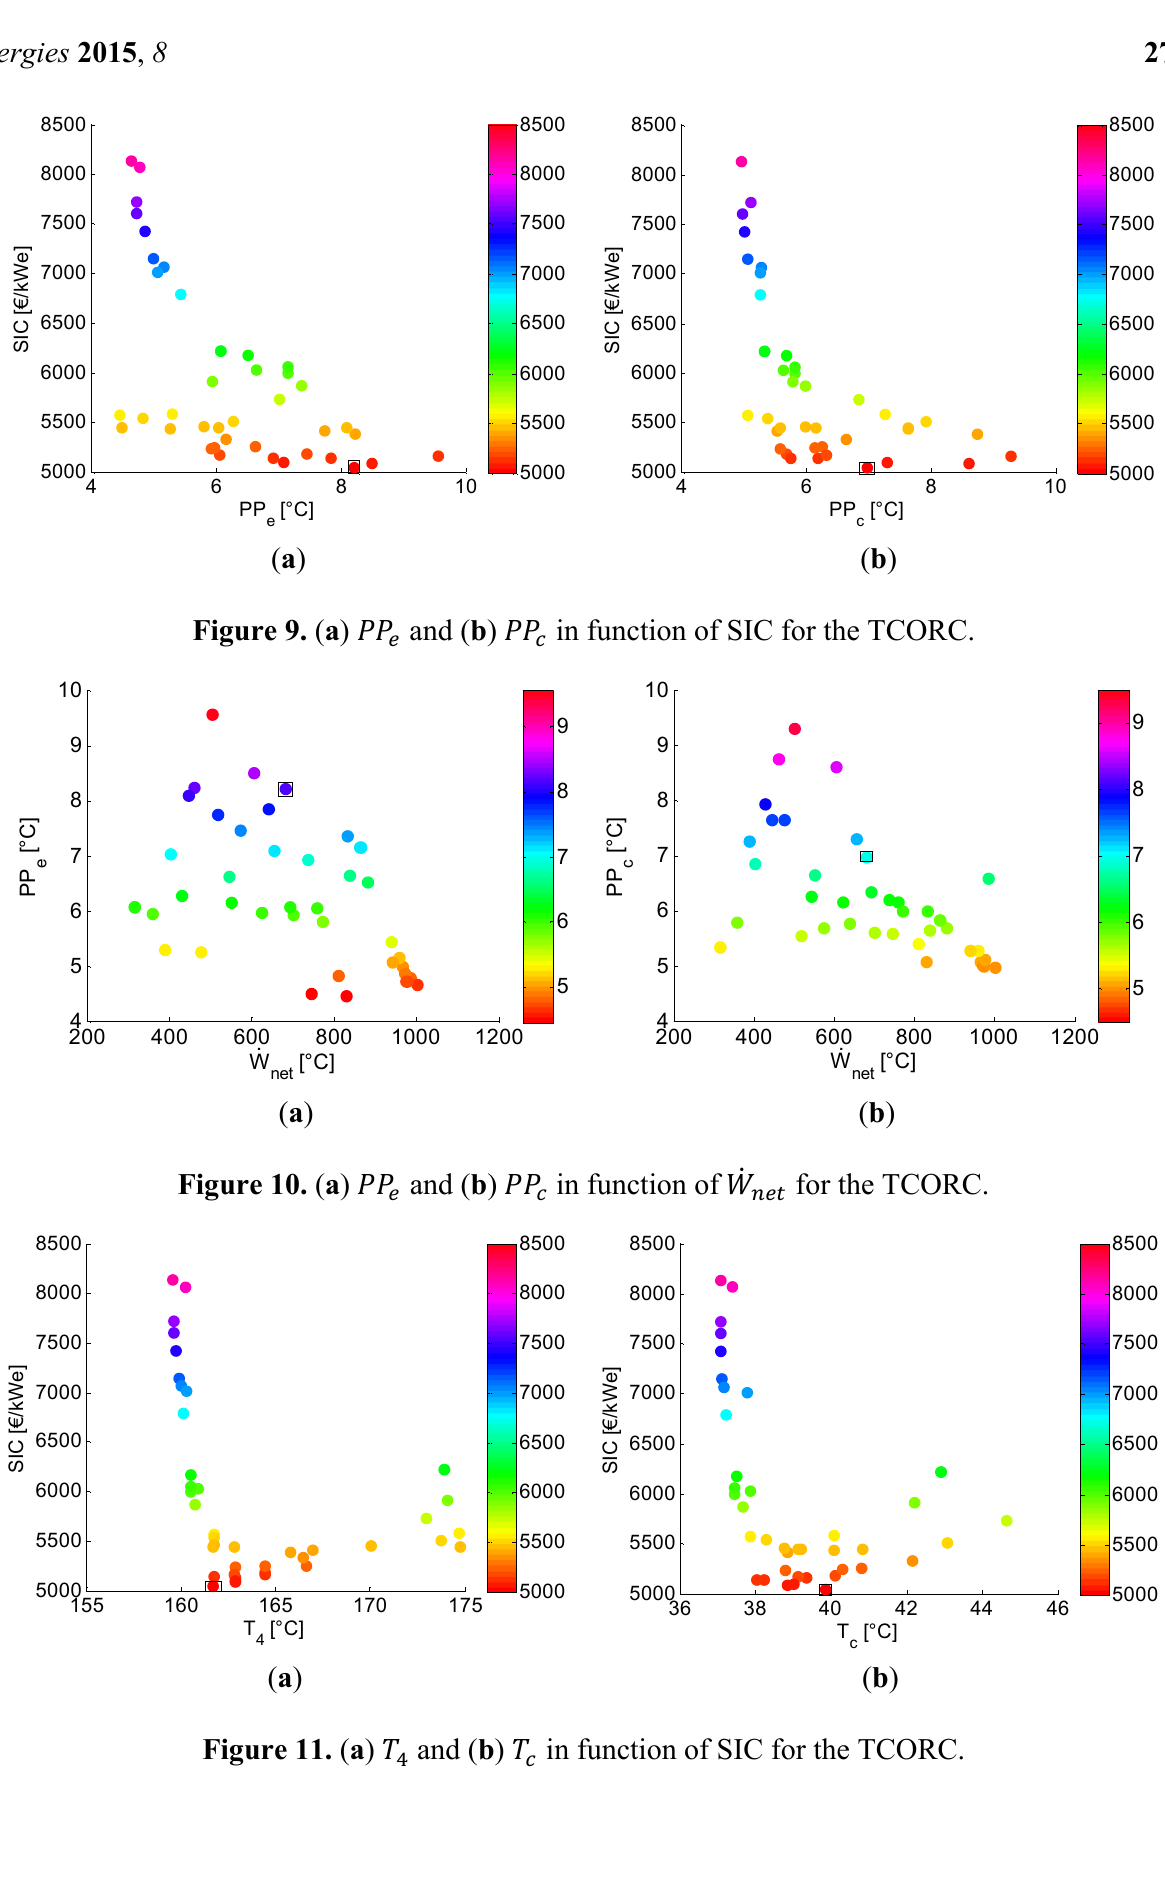
Figure 11. ( a ) (cid:1846)